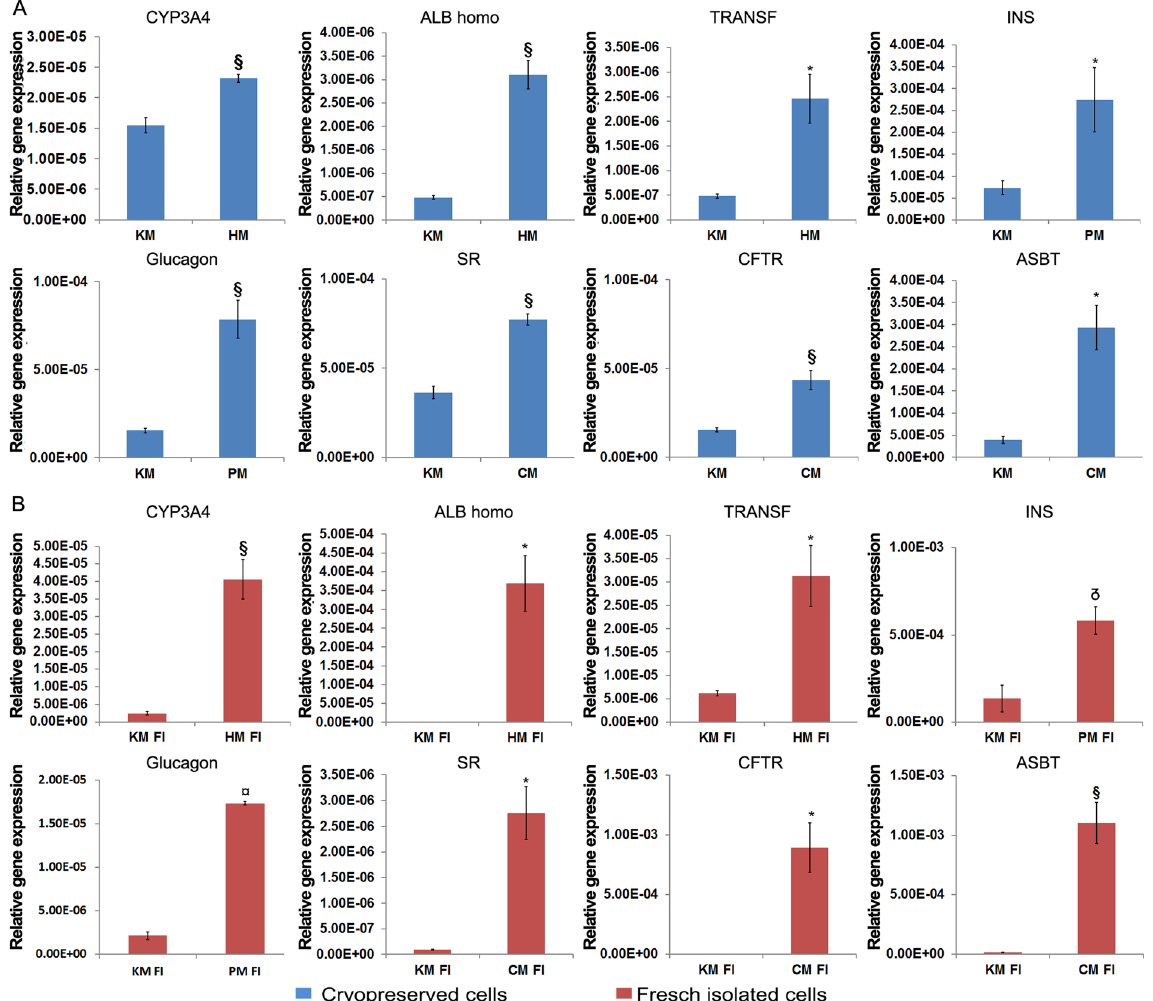
Figure 4. Expression of specific mature fate genes in cultures of cryopreserved or freshly isolated hBTSCs in self-renewal conditions (Kubota’s Medium-KM) or hormonally defined medium for particular endodermal mature fates (hepatoytic/HM, cholangiocytic/CM, pancreatic islets/PM). ( A ) Relative gene expression of CYP3A4, albumin (ALB), transferrin (TRANSF), insulin (INS), glucagon, Secretin Receptor (SR), CFTR, ASBT in cryopreserved hBTSCs cultured in different defined conditions. Previously cryopreserved hBTSCs cultured in self-renewal conditions in Kubota’s Medium (KM) increased the expression of specific genes associated with adult fateswhen transferred in the appropriate hormonally defined medium (hepatocytic/HM, cholangioytic/ CM, pancreatic islets/PM). Data are expressed as mean ± SD of 3 experiments; * p < 0.05; § p < 0.01; ¤p < 0.001; p < 0.0001. ( B ) Relative gene expression of CYP3A4, albumin (ALB), transferrin (TRANSF), insulin (INS), glucagon, Secretin Receptor (SR), CFTR, ASBT in freshly isolated hBTSCs cultured in different defined conditions. Freshly isolated hBTSCs cultured in self-renewal conditions in Kubota’s Medium (KM) increased the expression of specific genes associated with mature fates when transferred in the related hormonally defined medium (hepatocytic/HM, cholangiocytic/CM, pancreatic islets/PM). Data are expressed as mean ± SD of 3 experiments; * p < 0.05; § p < 0.01; ¤ p < 0.001; p <